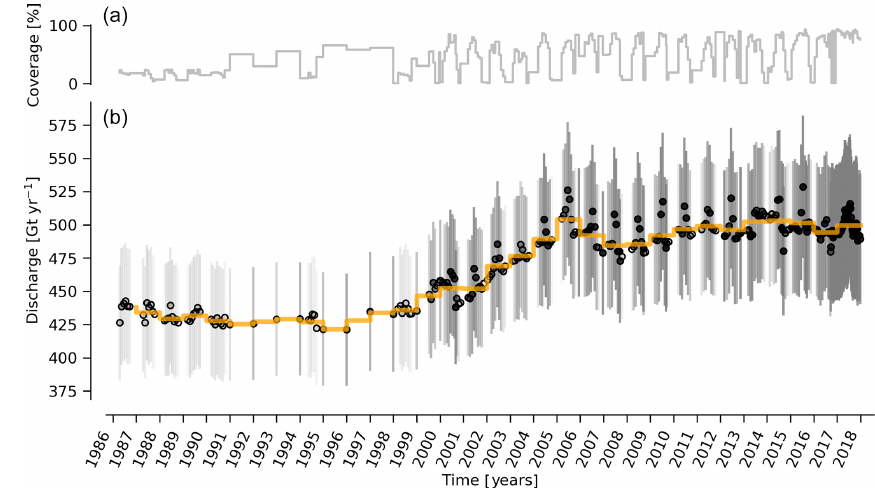
Figure 4. (b) Time series of ice discharge from the Greenland Ice Sheet. Dots represent when observations occurred. The orange stepped line is the annual average. Coverage (percentage of total discharge observed at any given time) is shown in (a) and also by the opacity of dot interior and error bars in panel (b) . When coverage is < 100%, total discharge is estimated and shown.